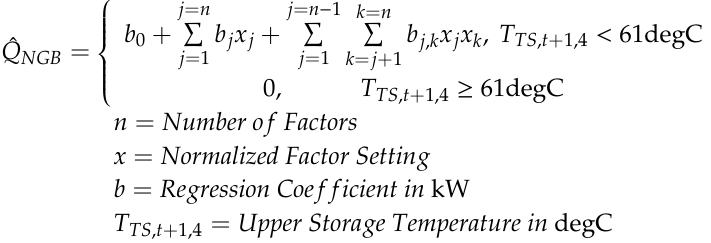
Figure 9. Left: Exemplary course of the boiler power prediction for one day based on different prediction horizons (if < 24 h, then one after another; time steps = 1 h) ( left ) as well as the distribution of the absolute error of these output prediction over the period of one year ( right ) with and without training phase.